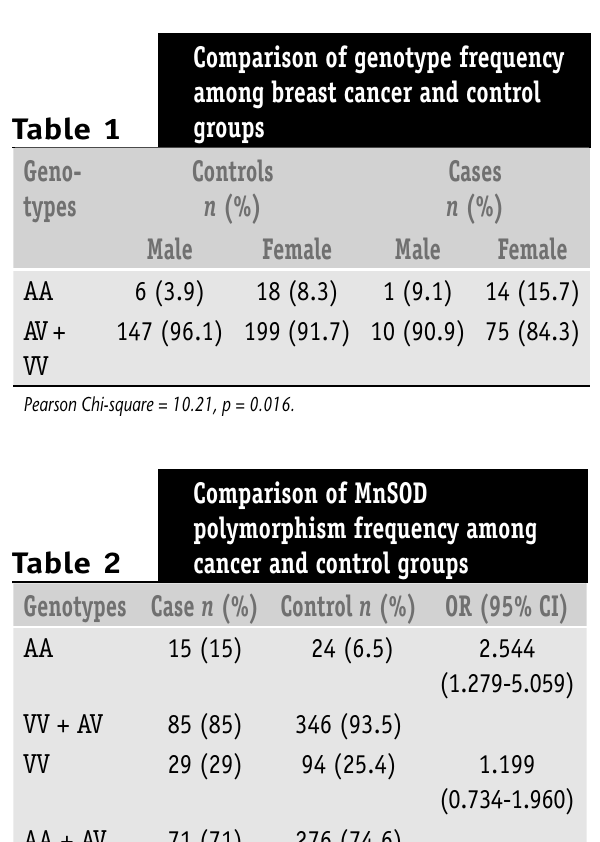
the sample in two general groups (case and controls) using the Pearson chi-square analysis. The results are described in Table 2 . Statistical differences were observed when case and control groups were compared for AA genotype (Pearson chi-square = 7.449; p =